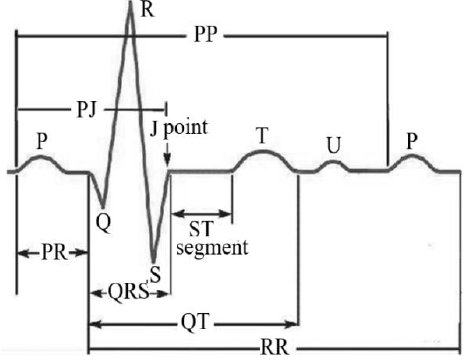
Figure 9. Typical ECG waveform.